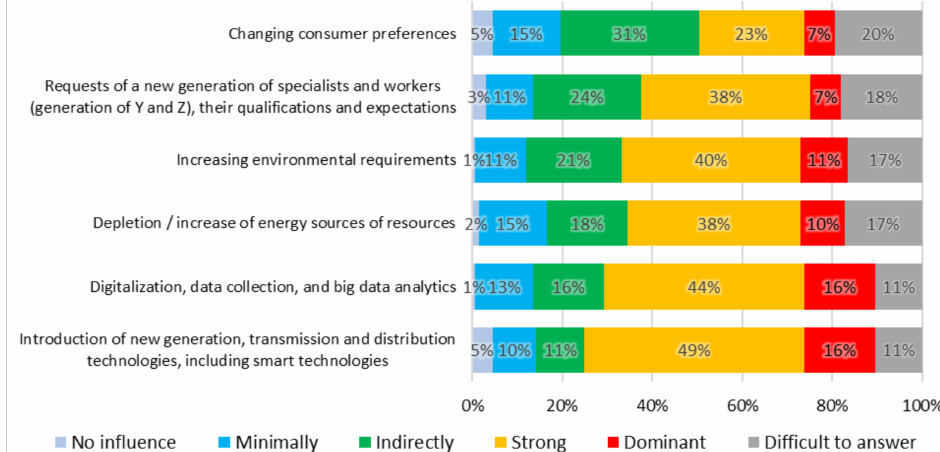
Figure 8. Expert assessment of the impact of major trends on the future of the energy industry in Kazakhstan. Source: compiled by the authors based on the results of the